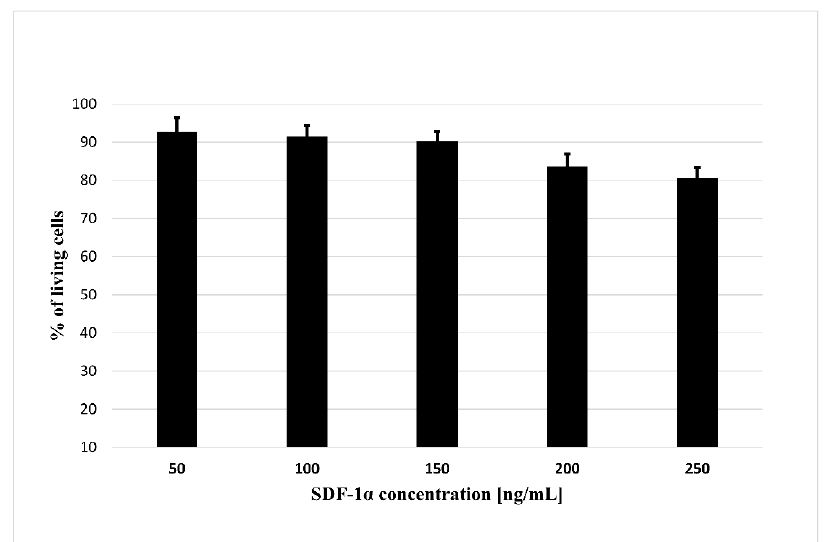
Figure 4. The cytotoxicity assay of the SDF- 1α. The assay was performed with bmMSC cells. The The results are presented as a% of cells surviving in the presence of the SDF-1 α in the range of results are presented as a% of cells surviving in the presence of the SDF- 1α in the range of concen- concentrations (50–250 ng/mL). The bars represent the means ± SD ( n = trations (50 – 250 ng/mL). The bars represent the means ± SD ( n = 3).